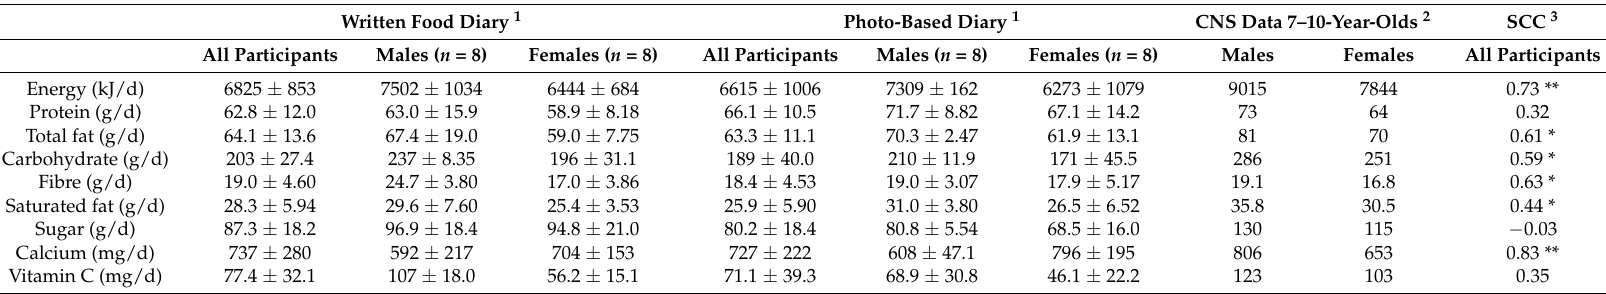
Table 1. Summary of key nutrients from written and photo-based diaries ( n = 16) compared to data from the Children’s Nutrition Survey in New Zealand (CNS) plus SCC for written and photo-based